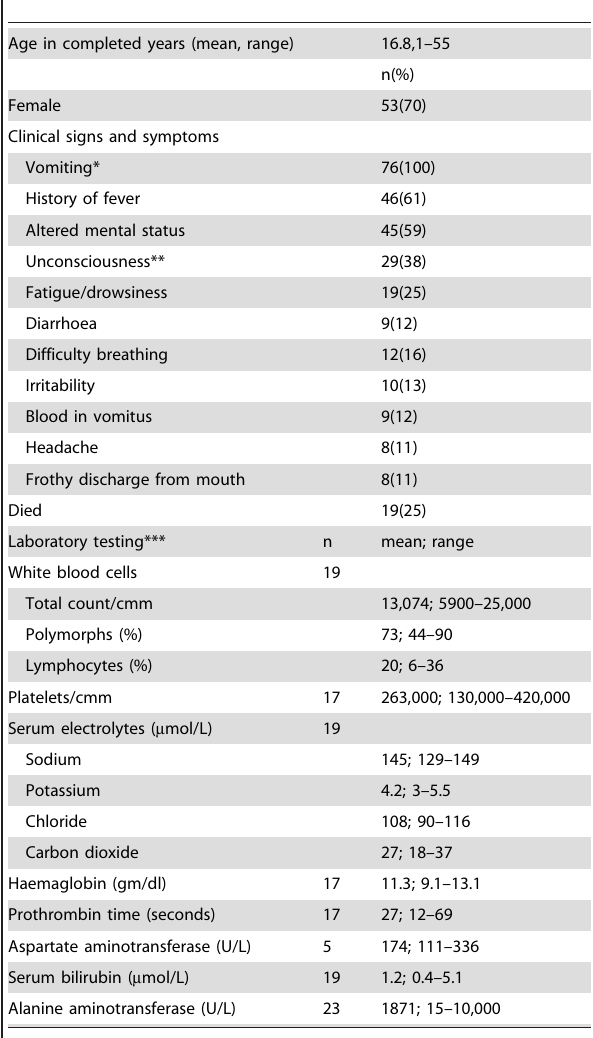
Table 1. Demographic characteristics and clinical description of suspect and probable cases (N